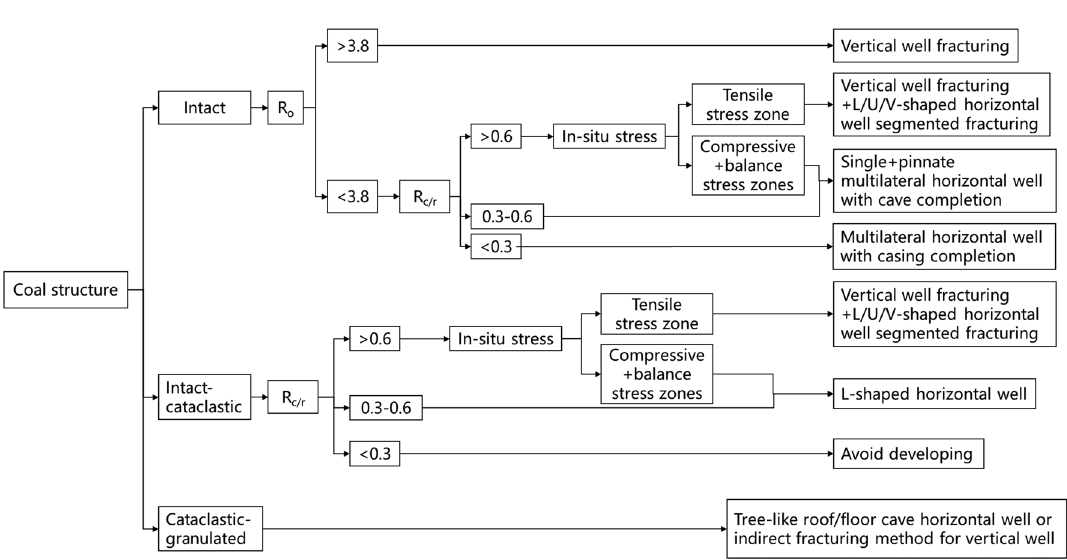
Fig. 15 Flow chart of CBM well type optimization technology, after Tao et al.